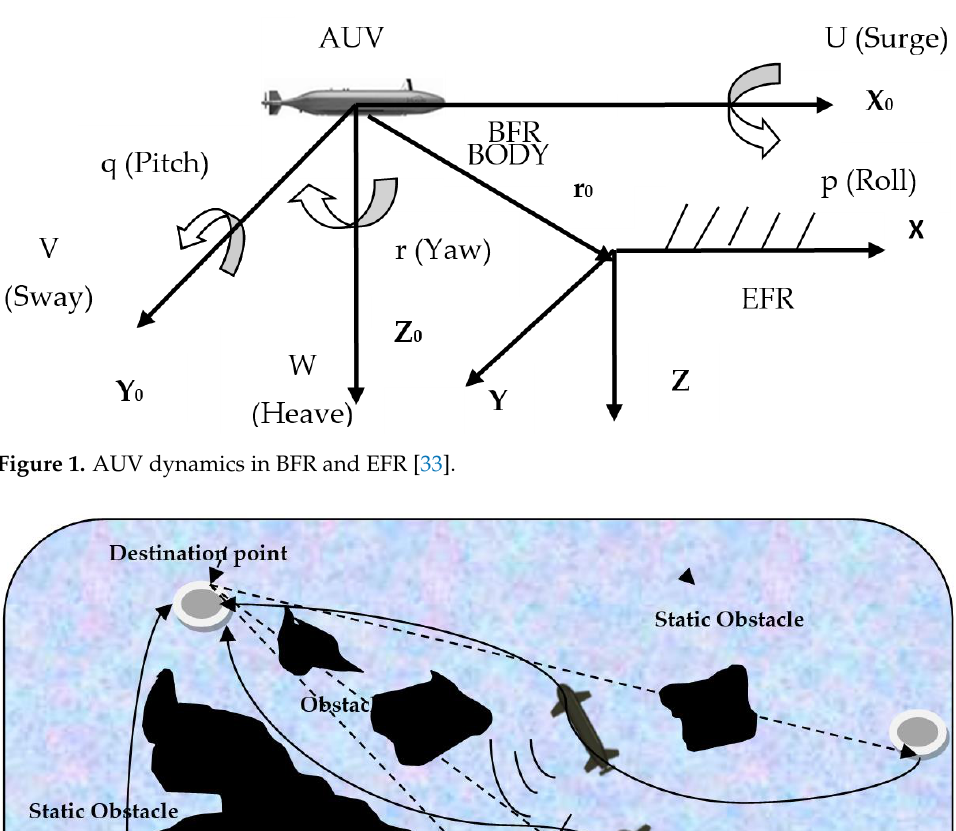
Figure 1. AUV dynamics in BFR and EFR [33].